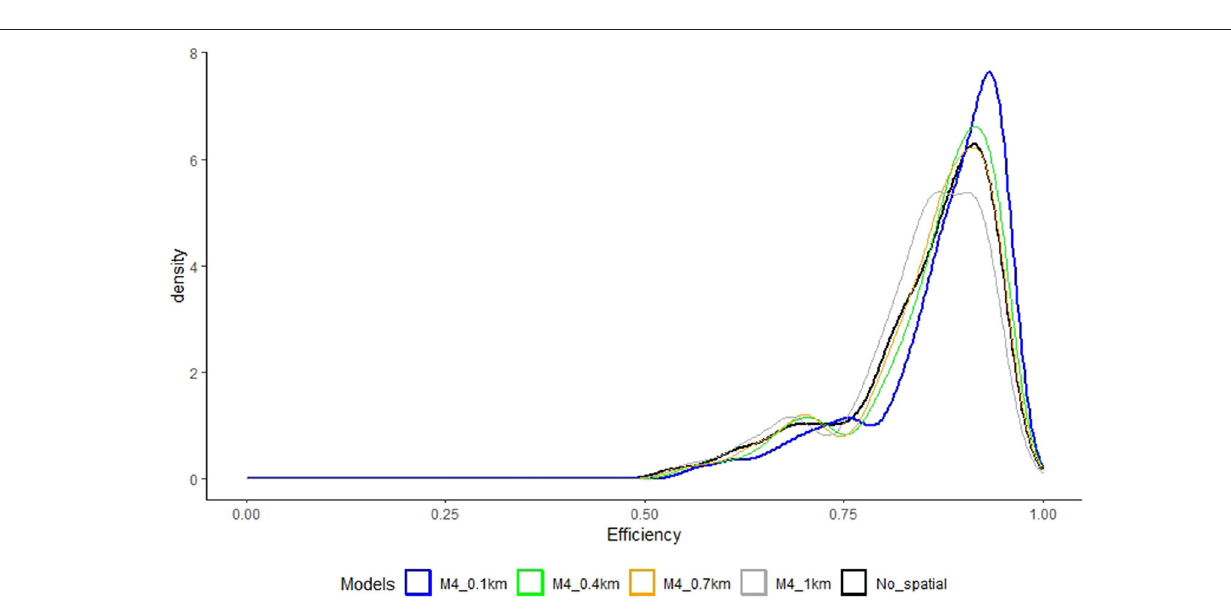
95% coverage posterior region in brackets. The interpretation of the Bayesian 95% coverage posterior (a, b) is that, according to our data and model, the parameter is between a and b with a 0.95